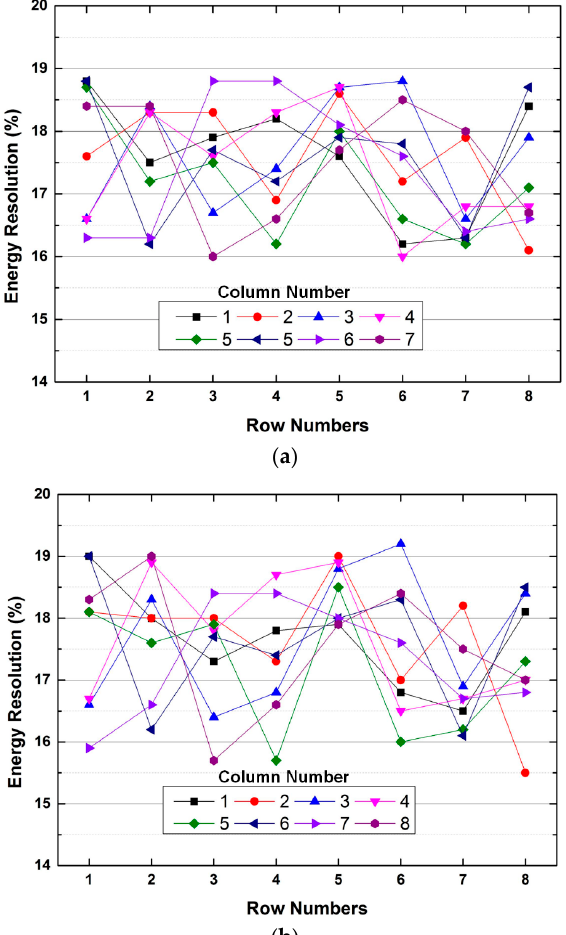
Figure 12. Measured energy resolution ( a ) without and ( b ) with two-step FSI.